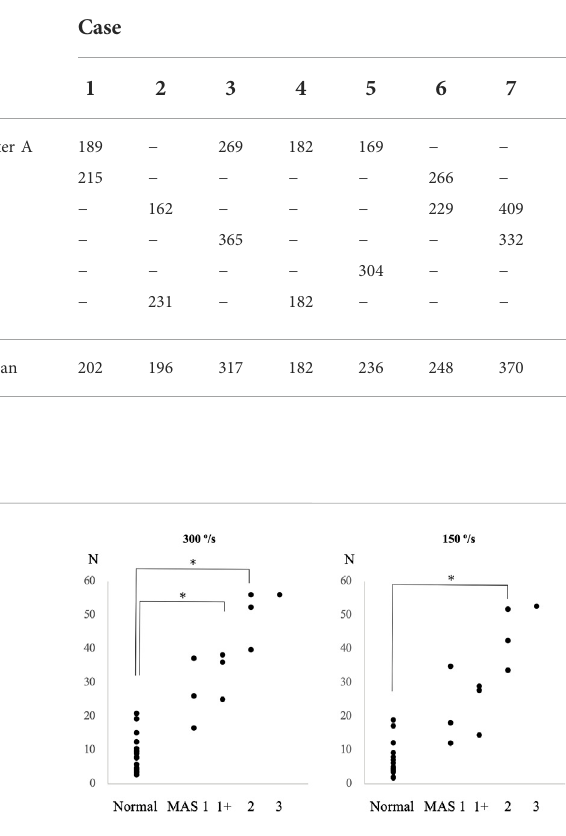
TABLE 2 Angular velocity of the ankle joint ( ° /s) according to the raters ’ manual assessment.